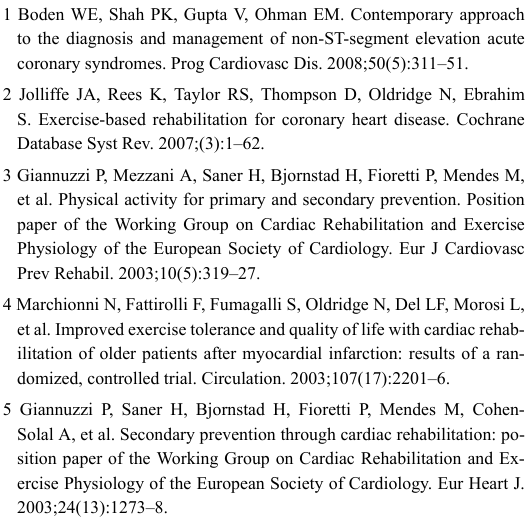
Table 4: Physical performance (cycle ergometer test) at the beginning, at the end and at the 12 months follow-up of rehabilitation (Watt). Start (S) of rehabilitation End (E) of rehabilitation 12 months follow-up (FU12) Delta (FU12-A) 1 Both groups 106.1 135.1 146.7 + 36.3 (p <.001 2 ) Inpatient